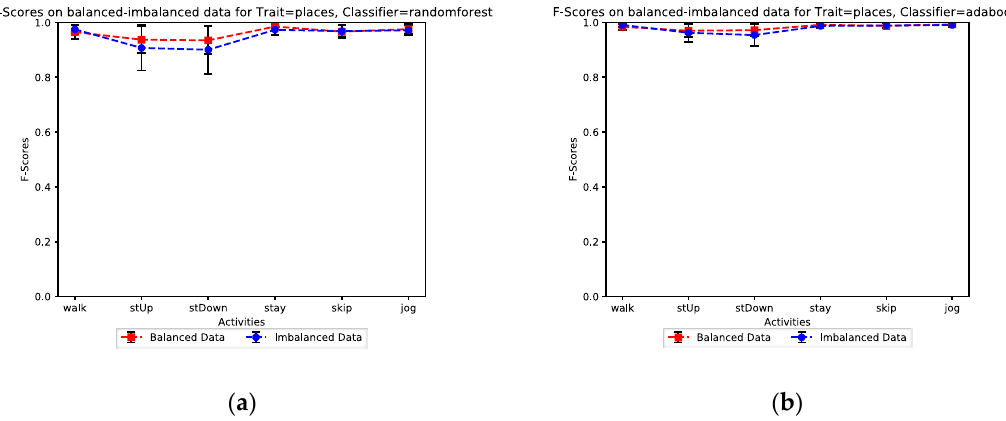
( b ) Figure 5. ( a ) The precision-recall performance and ( b ) the ROC graph of walk activity dataset for the Random Forest model in the combined accelerometer and gyroscope datasets scenario. 6.2.2. Impact of Unbalanced Data Data imbalance issues are common phenomena in various fields such as medical diagnosis, anomaly detection, economics, speaker recognition [48] and environmental concerns. They occur when the quantities of samples in datasets are not roughly equal. Most of the time, the learning process of a classifier leads to a proper fitting for dominant classes while it might be weak for minority classes, so one has to face imbalanced datasets. Oversampling the minority class and undersampling the majority class are two common solutions to deal with misbalanced datasets. Indeed, the public dataset HASC2016 is highly imbalanced so we must face this issue. In this work, instead of applying conventional methods such as a smoothing method, we manually balanced the dataset by carefully